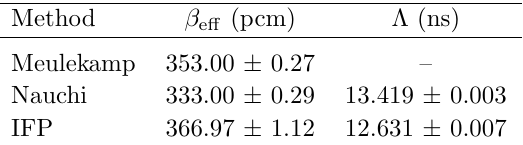
19. Serpent-evaluated Flattop-23 kinetics parameters.